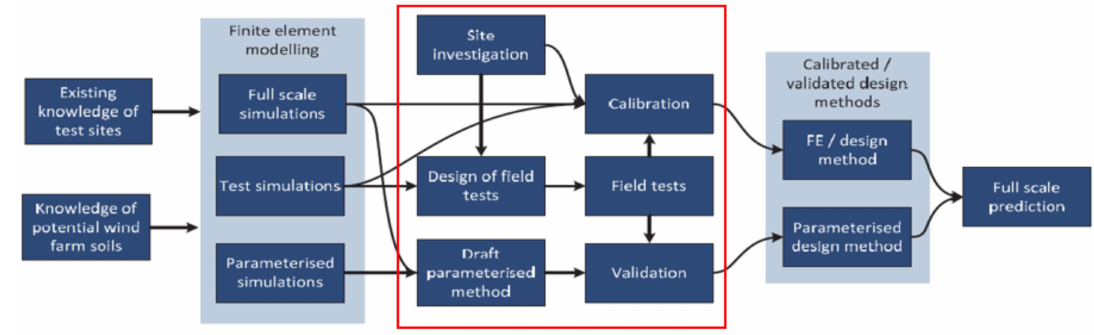
Figure 3. Overview of activity for the PISA